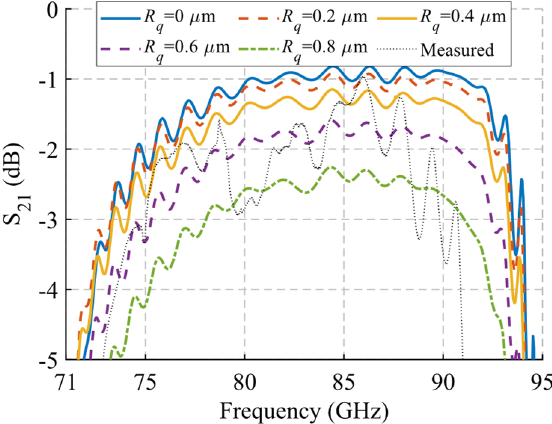
Figure 37. Analysis of the effect of roughness on the transmission parameter of the filter in glide symmetry position. It includes simulations for various roughness RMS Rq values overlapping with the measurement.